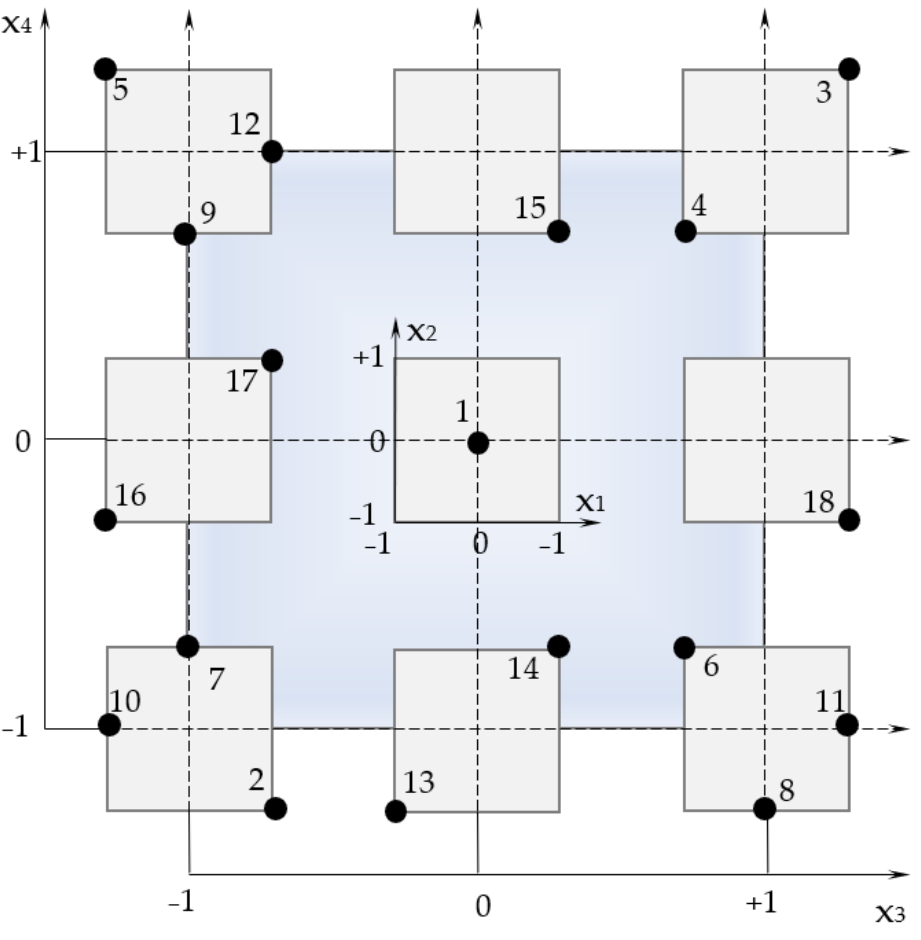
Figure 1. Points of the experiment design. Table 2. Levels of composition factors in the experiment.